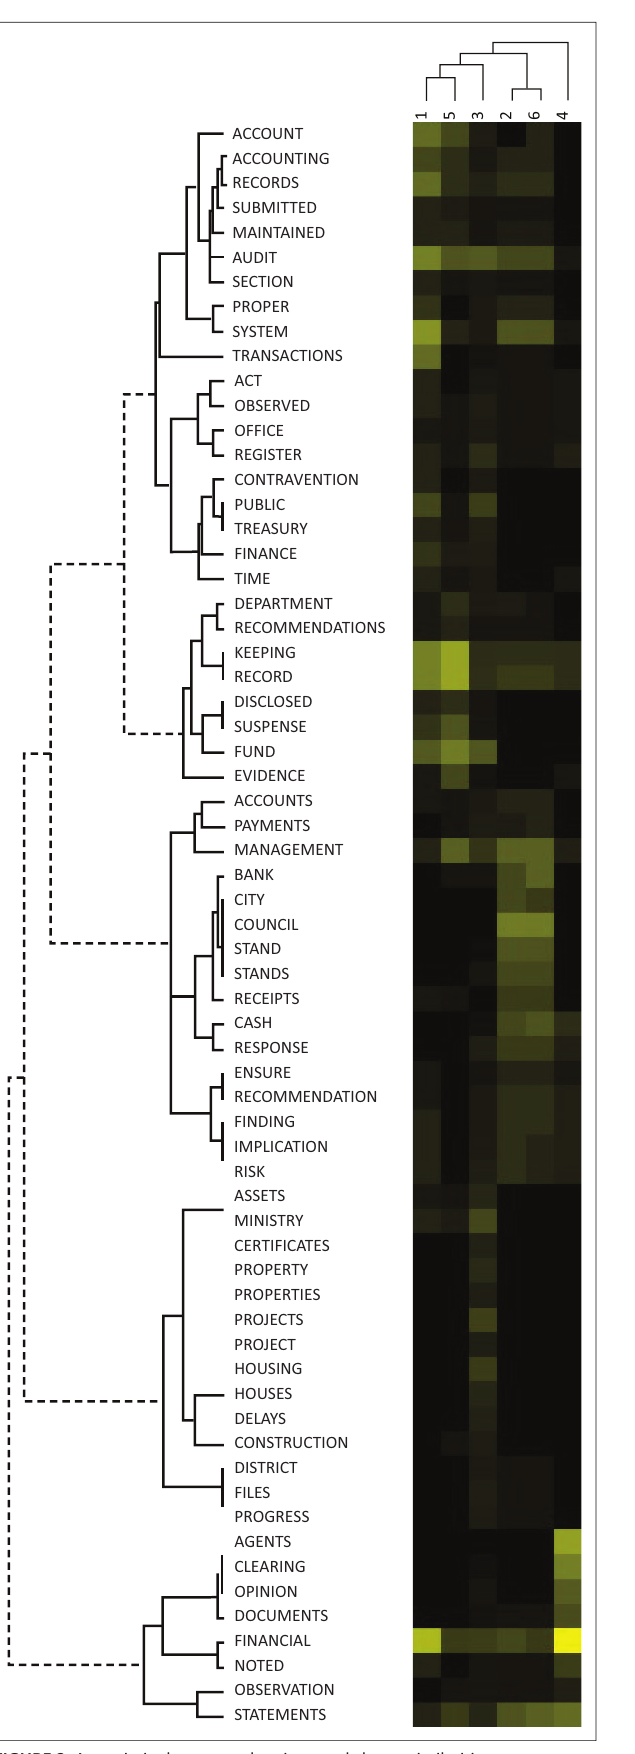
FIGURE 2: A proximity heat map showing word cluster